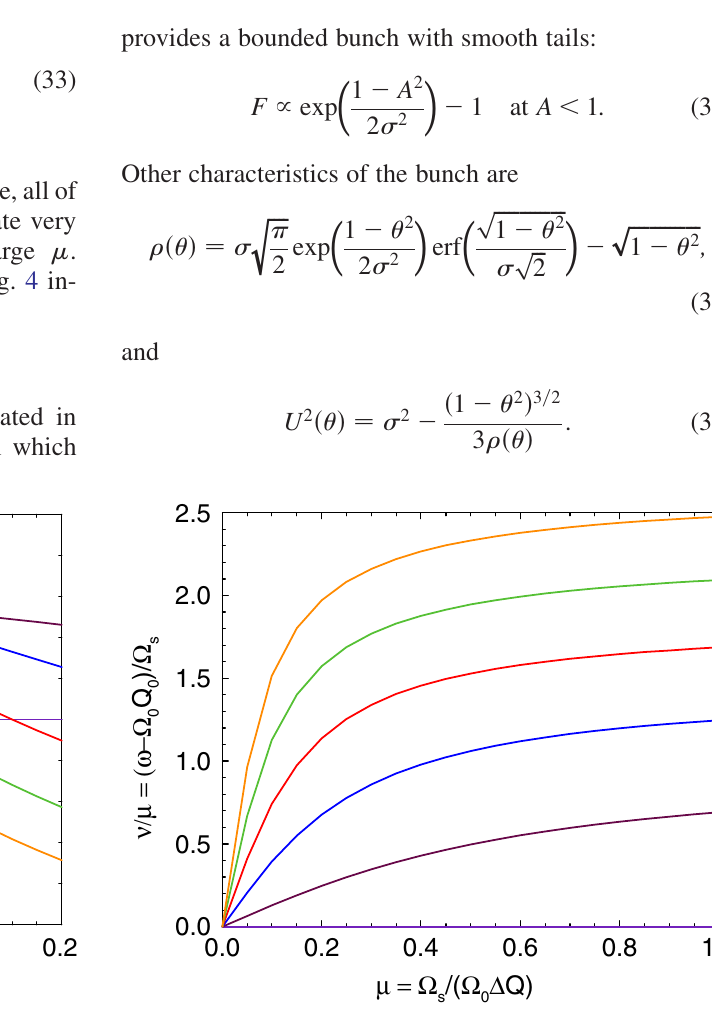
FIG. 9. (Color) Eigenvalues of the Gaussian bunch at (cid:10) ¼ 1 = 3 , higher (cid:7)